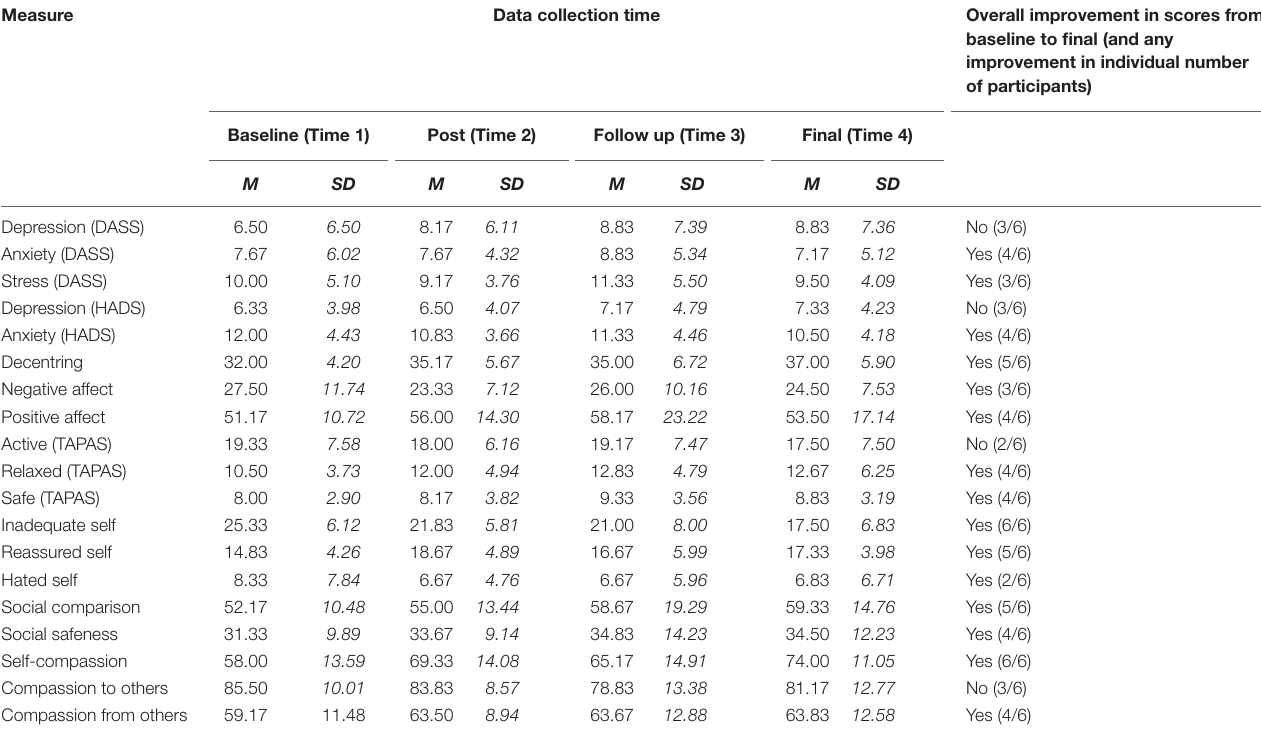
TABLE 2 | Mean scores and indicators of improvements for all self-report measures at baseline, post, follow up, and final data collection point. Measure Data collection time Overall improvement in scores from